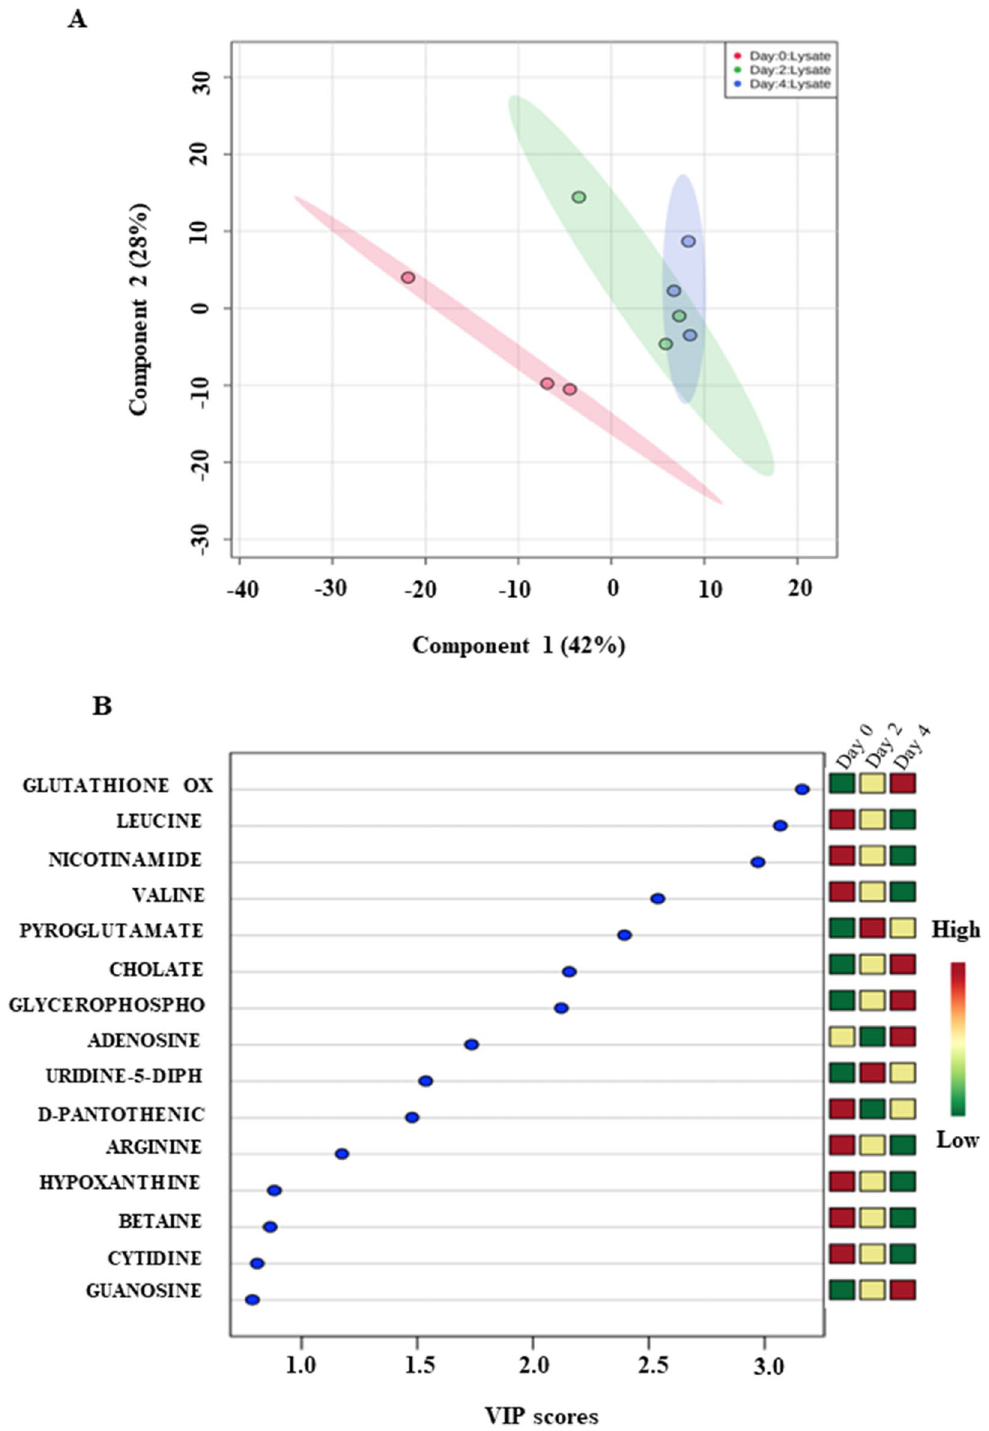
Figure 3. ( A ) Partial least square discriminate analysis (PLS-DA) scores plot of proliferating (Day 0), early differentiating (Day 2) and late differentiating myogenic culture (Day 4). First component versus second component showing the separation of myogenic culture (Day 0) to early (Day 2) and late differentiating myogenic culture (Day 4). Component 1 and 2 explaining about 70% of the data. ( B ) VIP scores with the corresponding expression heat map. Green and red indicates the low and high metabolites levels